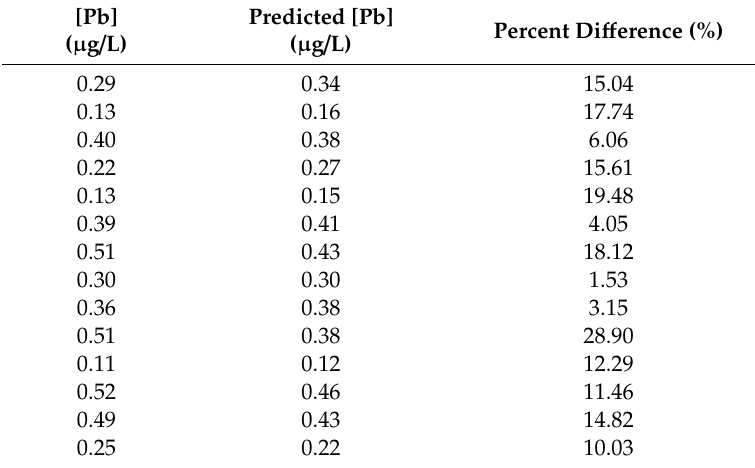
Table 5. Percent differences below 40% between predicted and actual Pb concentrations for the linear regression model displayed in Figure 6